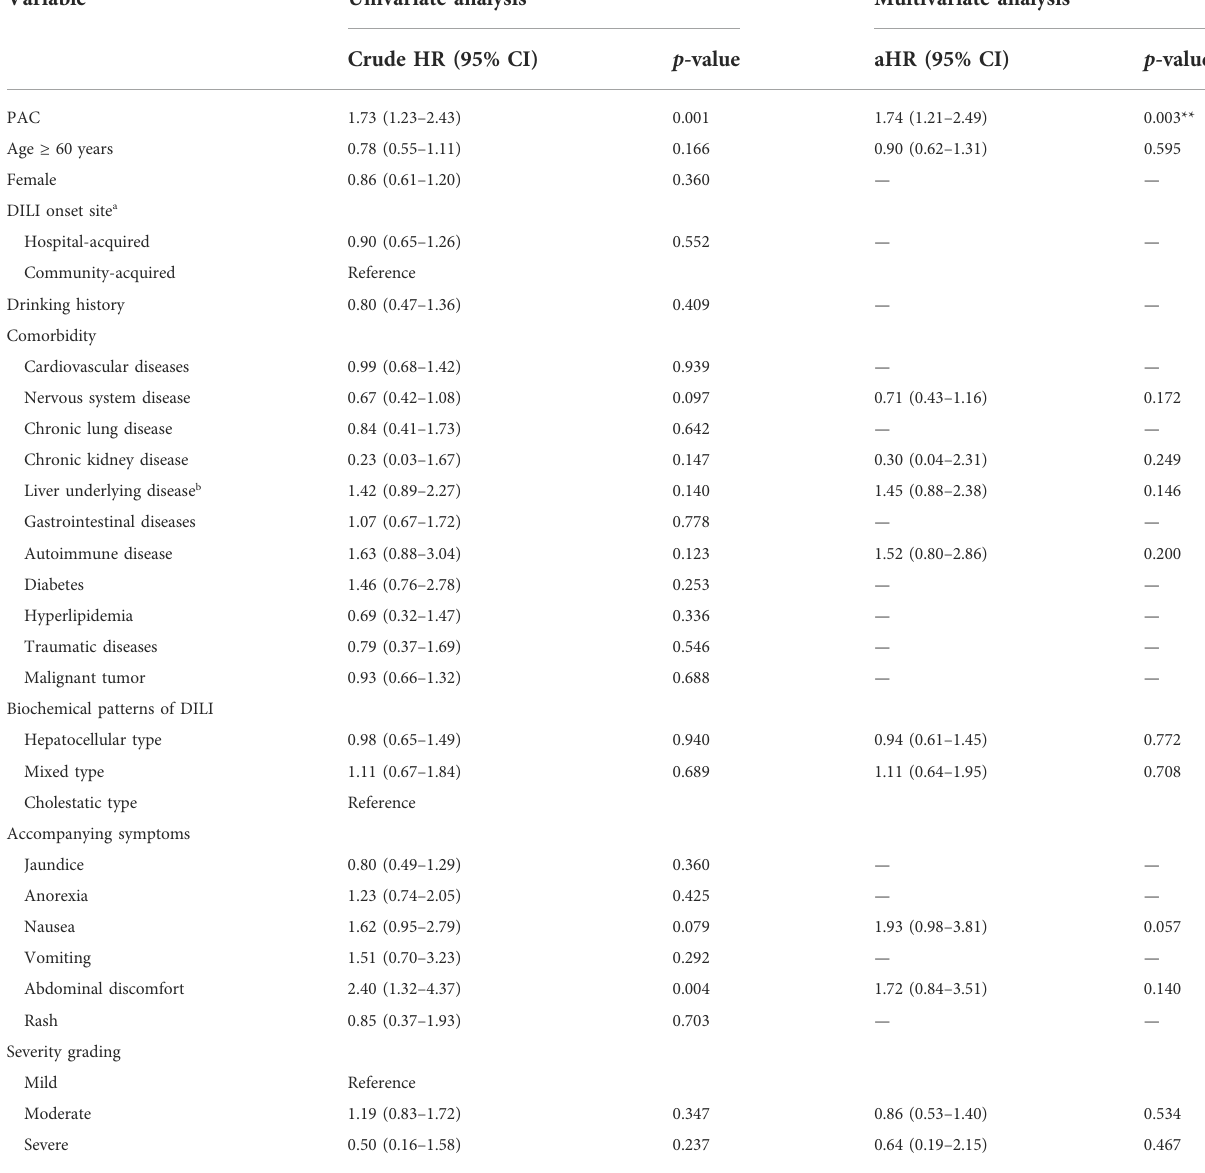
TABLE 4 Univariate and multivariate analyses to predict recovery in drug-induced liver injury